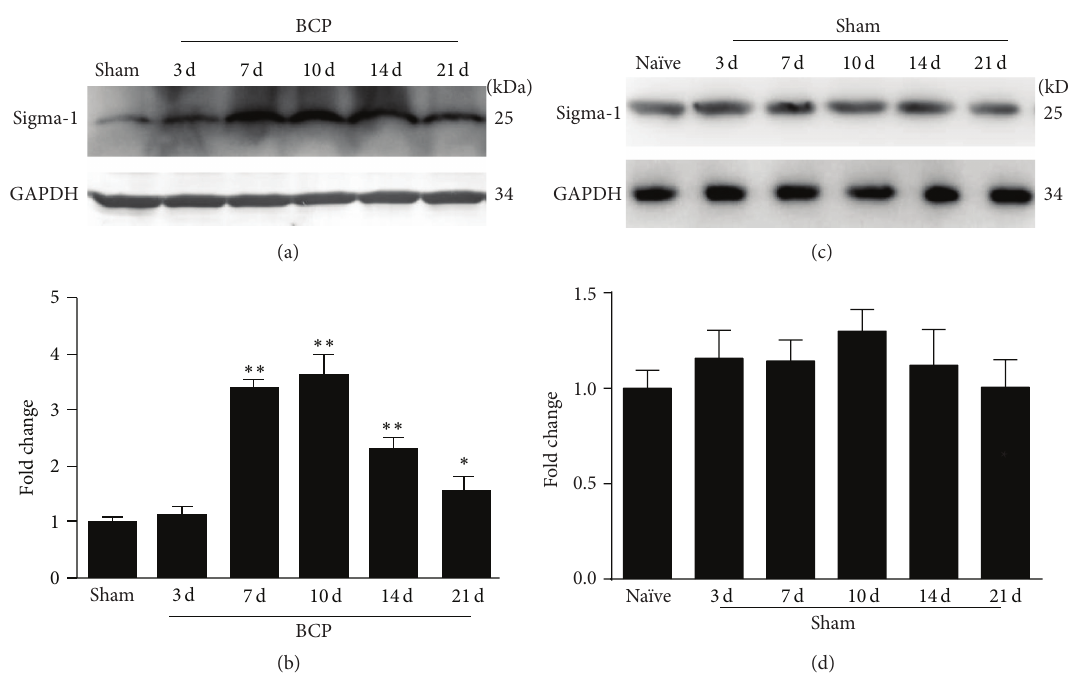
Figure 2: Walker 256 cells inoculation-induced sigma-1 receptor expression increased in the spinal cord. (a) Western blot analysis showed a significant upregulation of sigma-1 protein level in the spinal cord of BCP rats on days 7, 10, 14, and 21. GAPDH was used as a loading control. (b) Quantification of sigma-1 protein level in the spinal cord. (c) Western blot analysis showed no significant change of sigma-1 protein level in the spinal cord of sham rats on days 3, 7, 10, 14, and 21. GAPDH was used as a loading control. (d) Quantification of sigma-1 protein level in the spinal cord. Sigma-1 receptor levels were normalized against GAPDH ( 𝑛 = 4 ). Results are given as means ± SEM. ∗ 𝑃 < 0.05 , ∗∗ 𝑃 < 0.01 versus sham group or na¨ıve group.